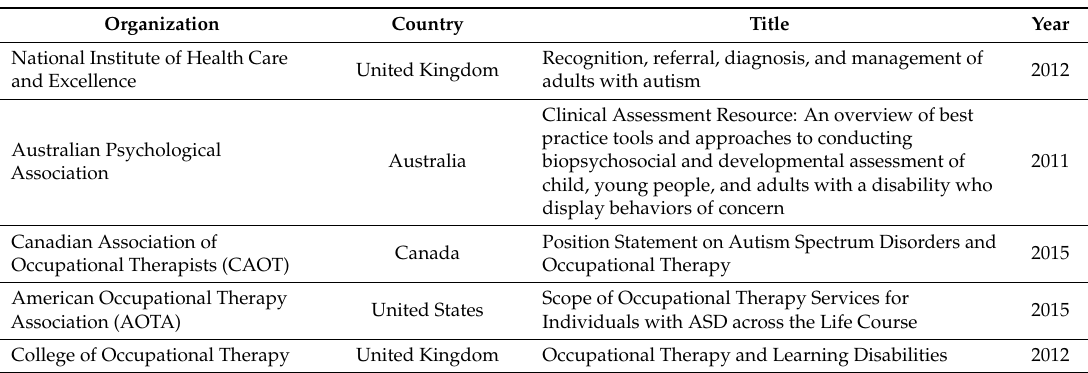
Table 2. Included Clinical Practice